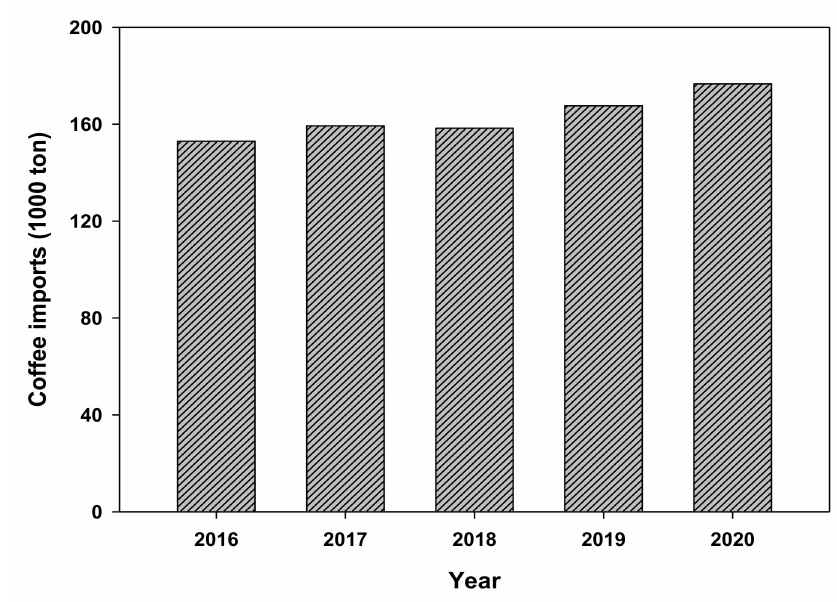
Figure 1. Coffee imports from 2015 to 2020 in South